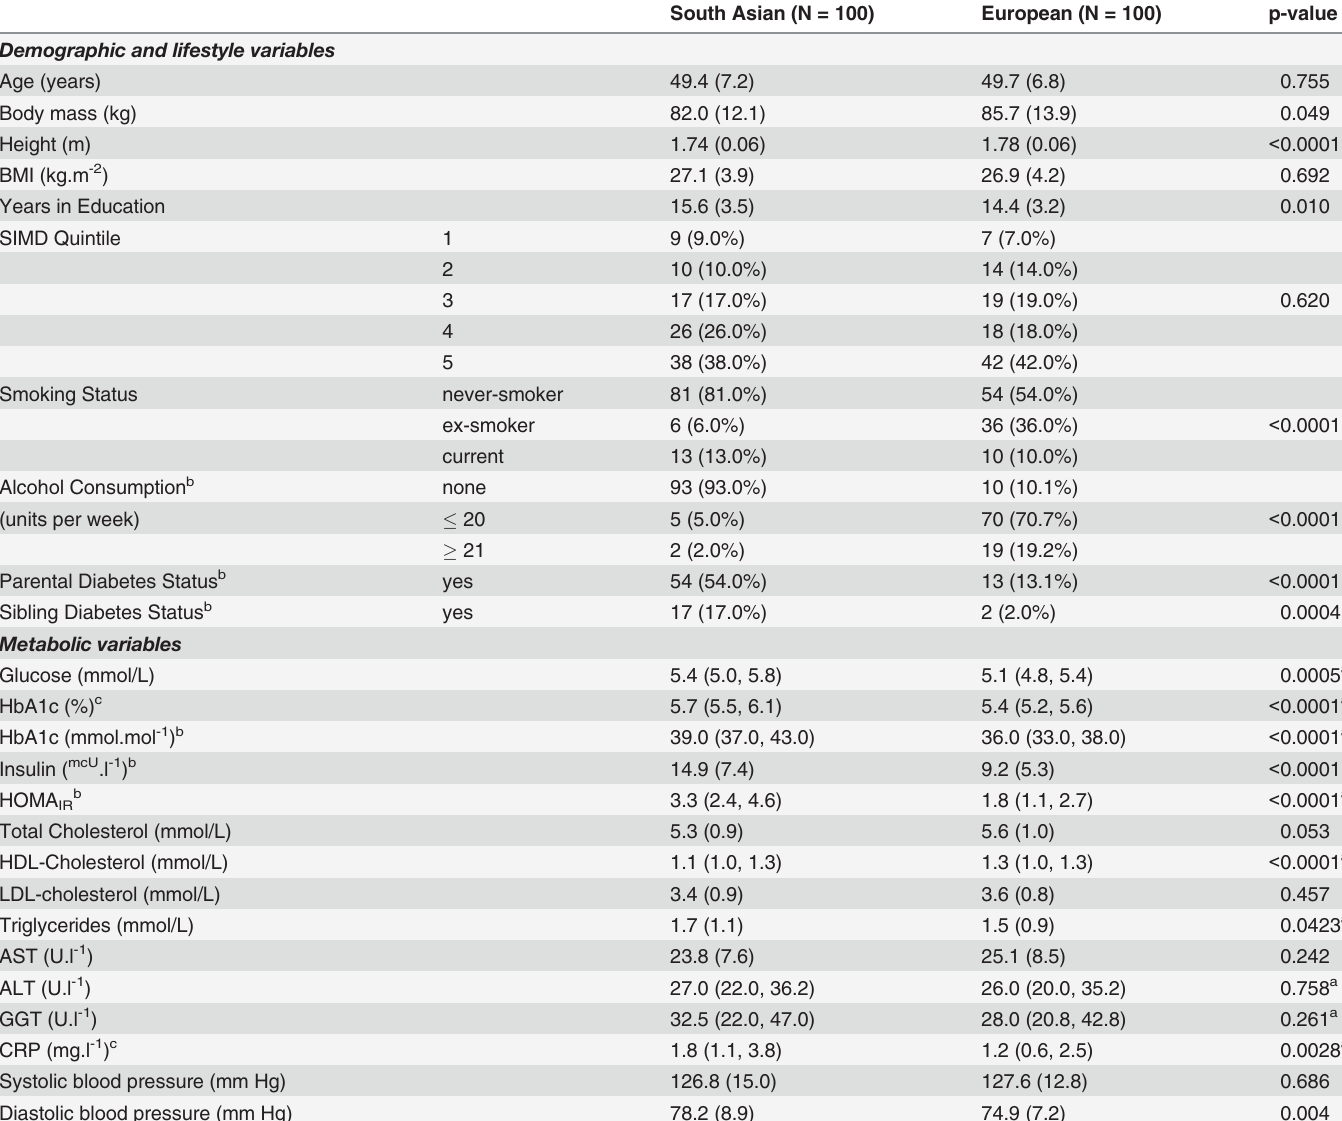
Table 1. Demographic and metabolic variables for all South Asian and European